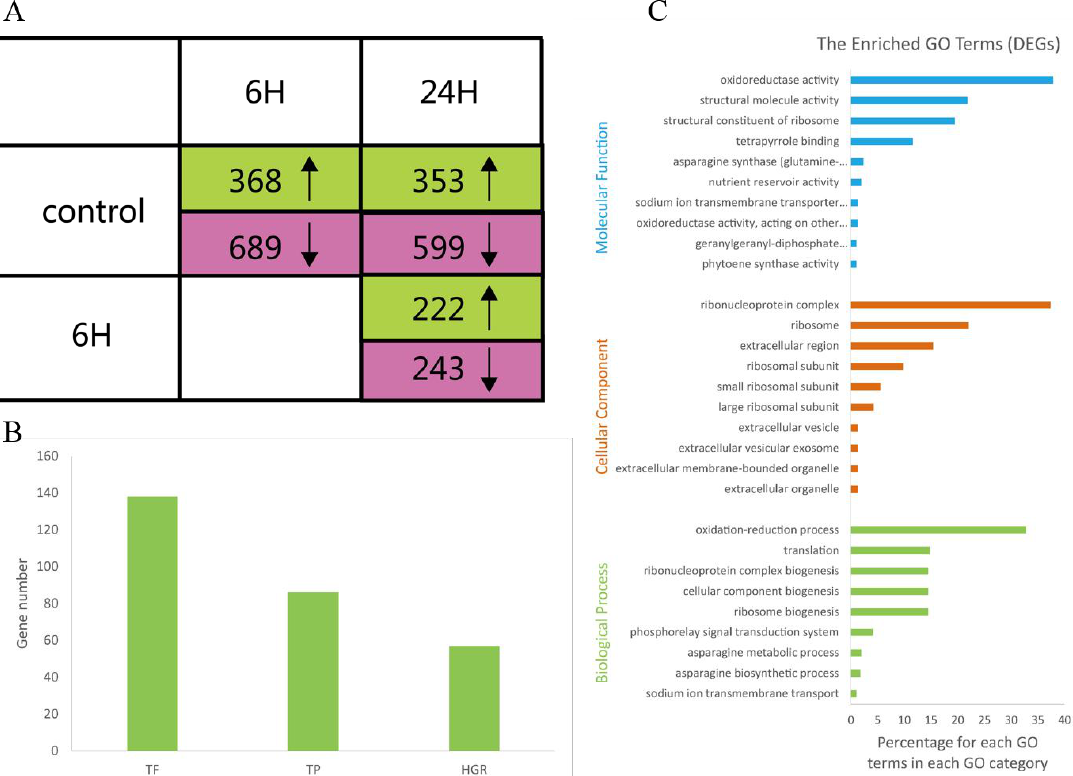
Figure 2. Transcriptomes analysis of A. splendens with three comparisons: (i) 6 vs. 0 h; (ii) 24 vs. 0 h; and (iii) 24 vs. 6 h. ( A ) Numbers of DEGs that were upregulated (green) and downregulated (pink) in the three comparisons (FDR <0.001; upregulated: fold change >2; and downregulated: fold change <0.5); ( B ) numbers of total DEGs and DEGs annotated as transcription factors (TFs), transporter proteins (TPs), and hormone-related genes (HRGs); and ( C ) GO terms that were overrepresented among the DEGs (color figure online).